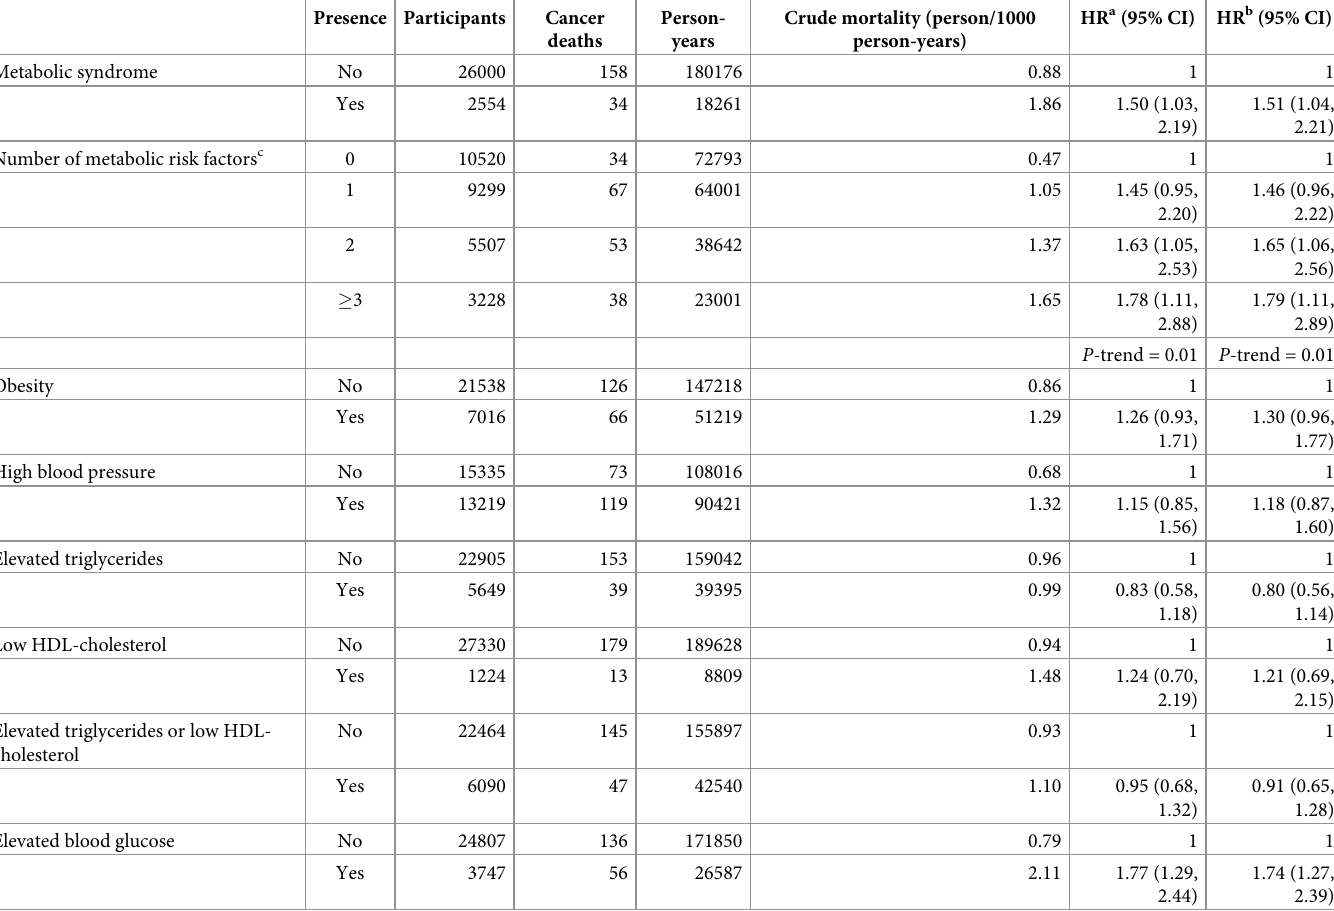
Table 4. Hazard ratios and 95% confidence intervals for total cancer mortality in relation to metabolic syndrome and its components diagnosed using the criteria of Japan Society for the Study of Obesity with